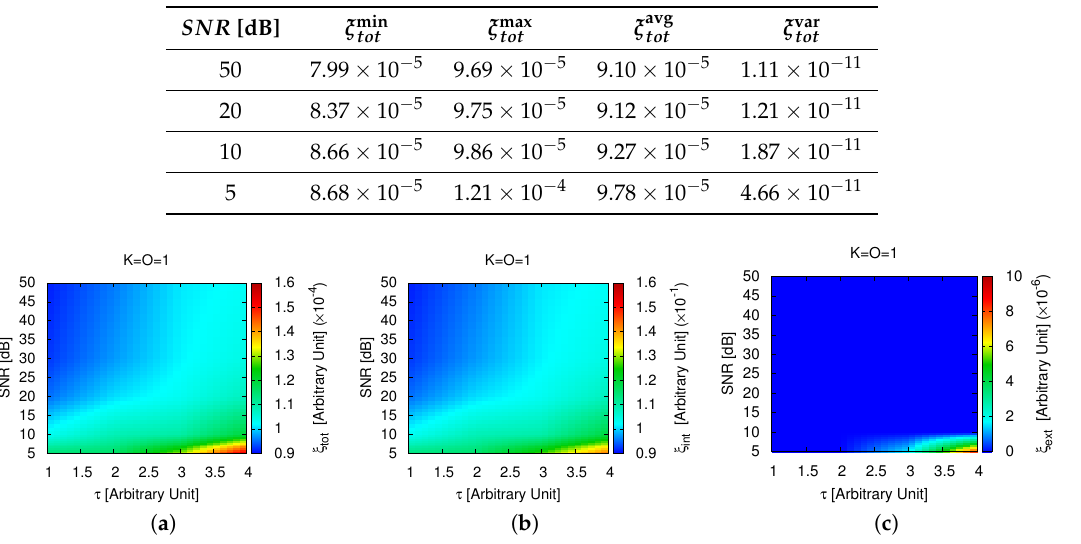
Figure 4. Numerical Assessment ( K = 1, O = 1, τ ∈ [ 1.0, 4.0 ] , SNR ∈ [ 5, 50 ] [dB])—Behavior of the ( a ) total ( ξ tot ); ( b ) internal ( ξ int ); and ( c ) external ( ξ ext ) reconstruction errors when processing the scattering data with the MT-BCS